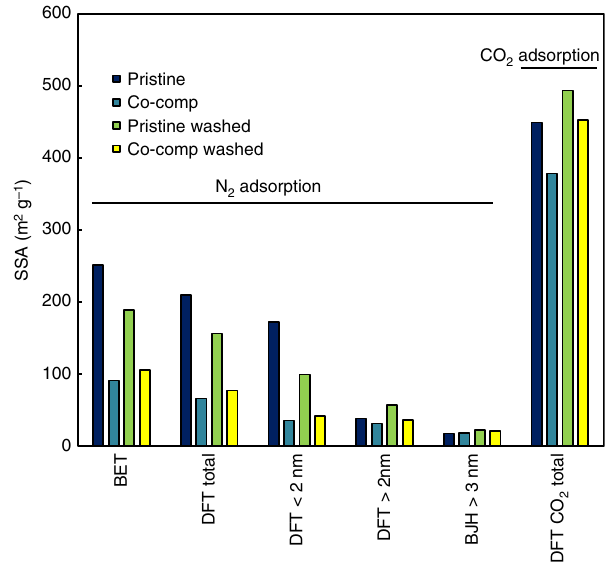
Fig. 8 Speci fi c surface area (SSA) according to N 2 and CO 2 gas adsorption. Total SSA according to the Brunauer, Emmett and Teller method, total SSA according to the quenched-solid density functional theory (QSDFT) method, SSA due to micropores according to the QSDFT method, SSA for mesopores up to 34 nm according to the QSDFT method, SSA for pores bigger than 3 nm according to the Barrett, Joyner and Halenda method and SSA of micropores with CO 2 adsorption and applying the non local density function theory method of pristine and co-composted biochar, pristine biochar after washing and co-composted biochar after